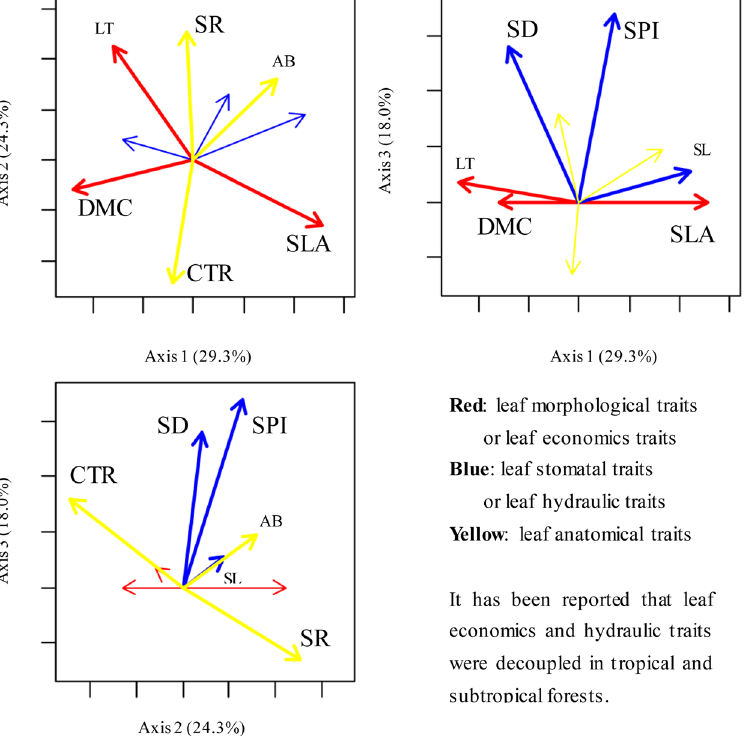
Figure 2. Principal component analyses. DMC, dry matter content; SLA, specific leaf area; LT, leaf thickness; SL, stomatal pore length; SD, stomatal density; SPI, stomatal area index; CTR, cell tense ratio; SR, spongy tissue ratio; AB, abaxial cell thickness.